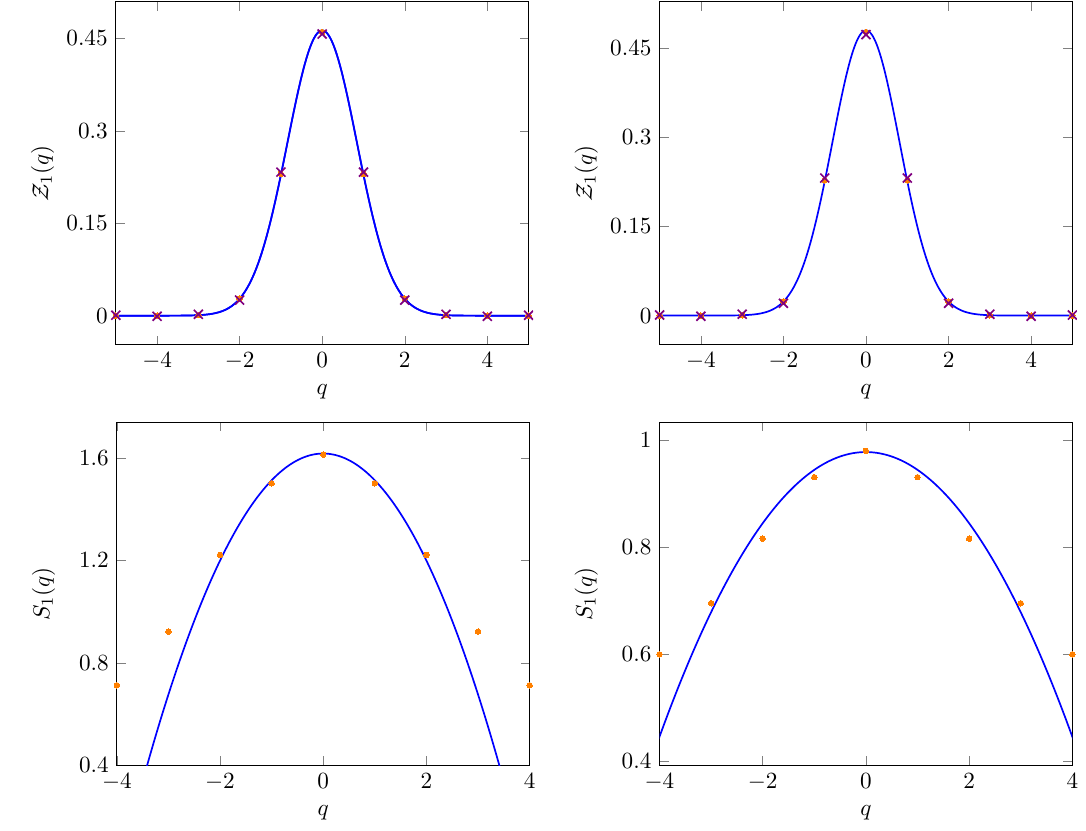
40 . 4 2 0 2 − − Figure 4 . Top panels: symmetry resolved moments Z n ( q ) for n = 1 , computed with the saddle point approximation in eq. (3.31) (blue continuous line), with a numerical Fourier transform of the field theory charged moments in eq. (3.21) (cross mark) and with the lattice model (orange dots), for N = 300 . The values of the parameters are β = 10 L and r = 0 . 3 L , where r is the size of the interval defining the subsystem. The plot on the left is obtained in the spin sector ν = 2 , the other one corresponds to ν = 3 . Bottom panels: symmetry resolved entanglement entropy in the spin sector ν = 2 (left) and ν = 3 (right) for a subsystem made of a single interval of length 0 . 3 L , at β = 10 L . The blue continuous line represents the result obtained from the field theory with the saddle point approximation in eq. (3.32) and the orange dots show, instead, the numerical result for a finite lattice model ( N = 300